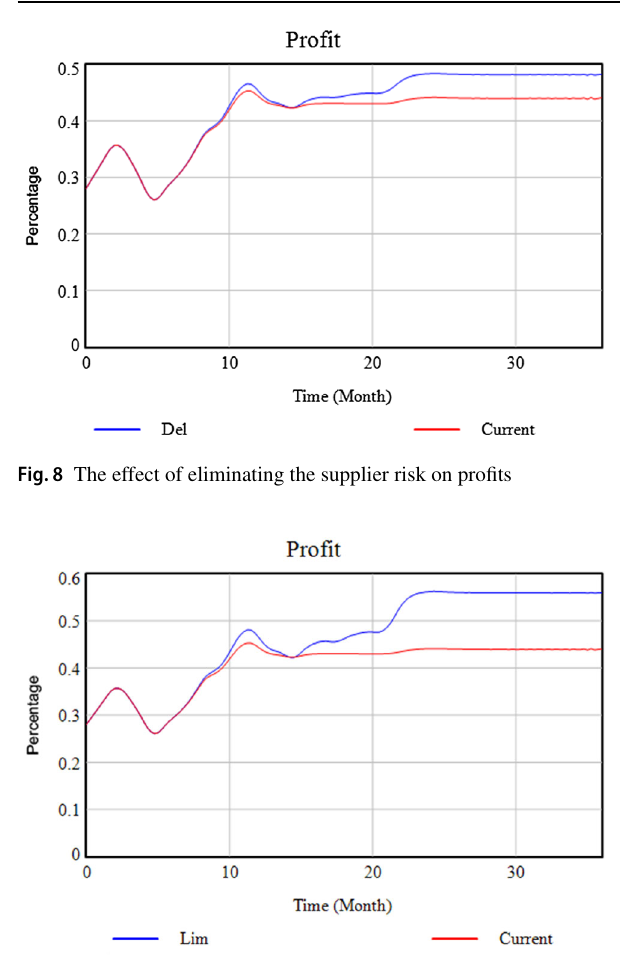
Fig. 9 Model behavior when the supplier risk rate is close to zero